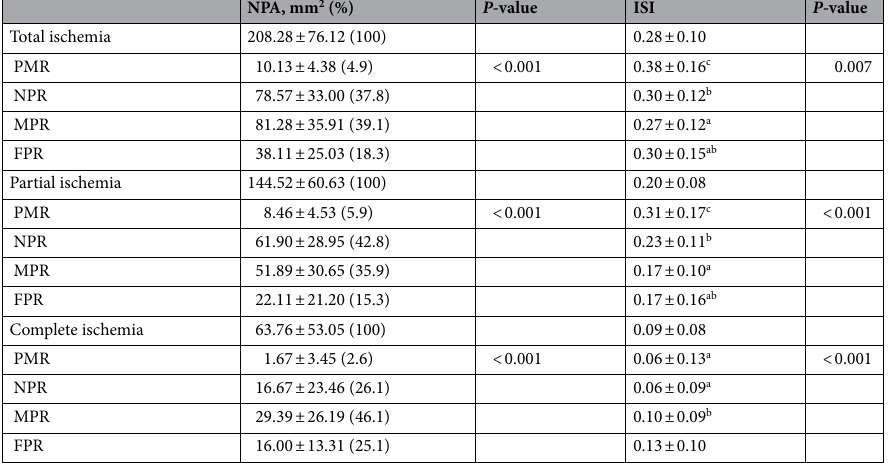
Table 2. Distribution of ischemic area within different retinal zones. FPR: far-peripheral region, ISI: ischemic index, MPR: mid-peripheral region, NPA: non-perfusion area, NPR: near-peripheral region, PMR: peri- macular region. Numerical data are presented as mean ± standard deviation. P -values were calculated using Friedman test. The letters a, b, c denote statistical significance between each group of post-hoc comparison: groups sharing the same letter do not significantly differ by Wilcoxon signed-rank test.